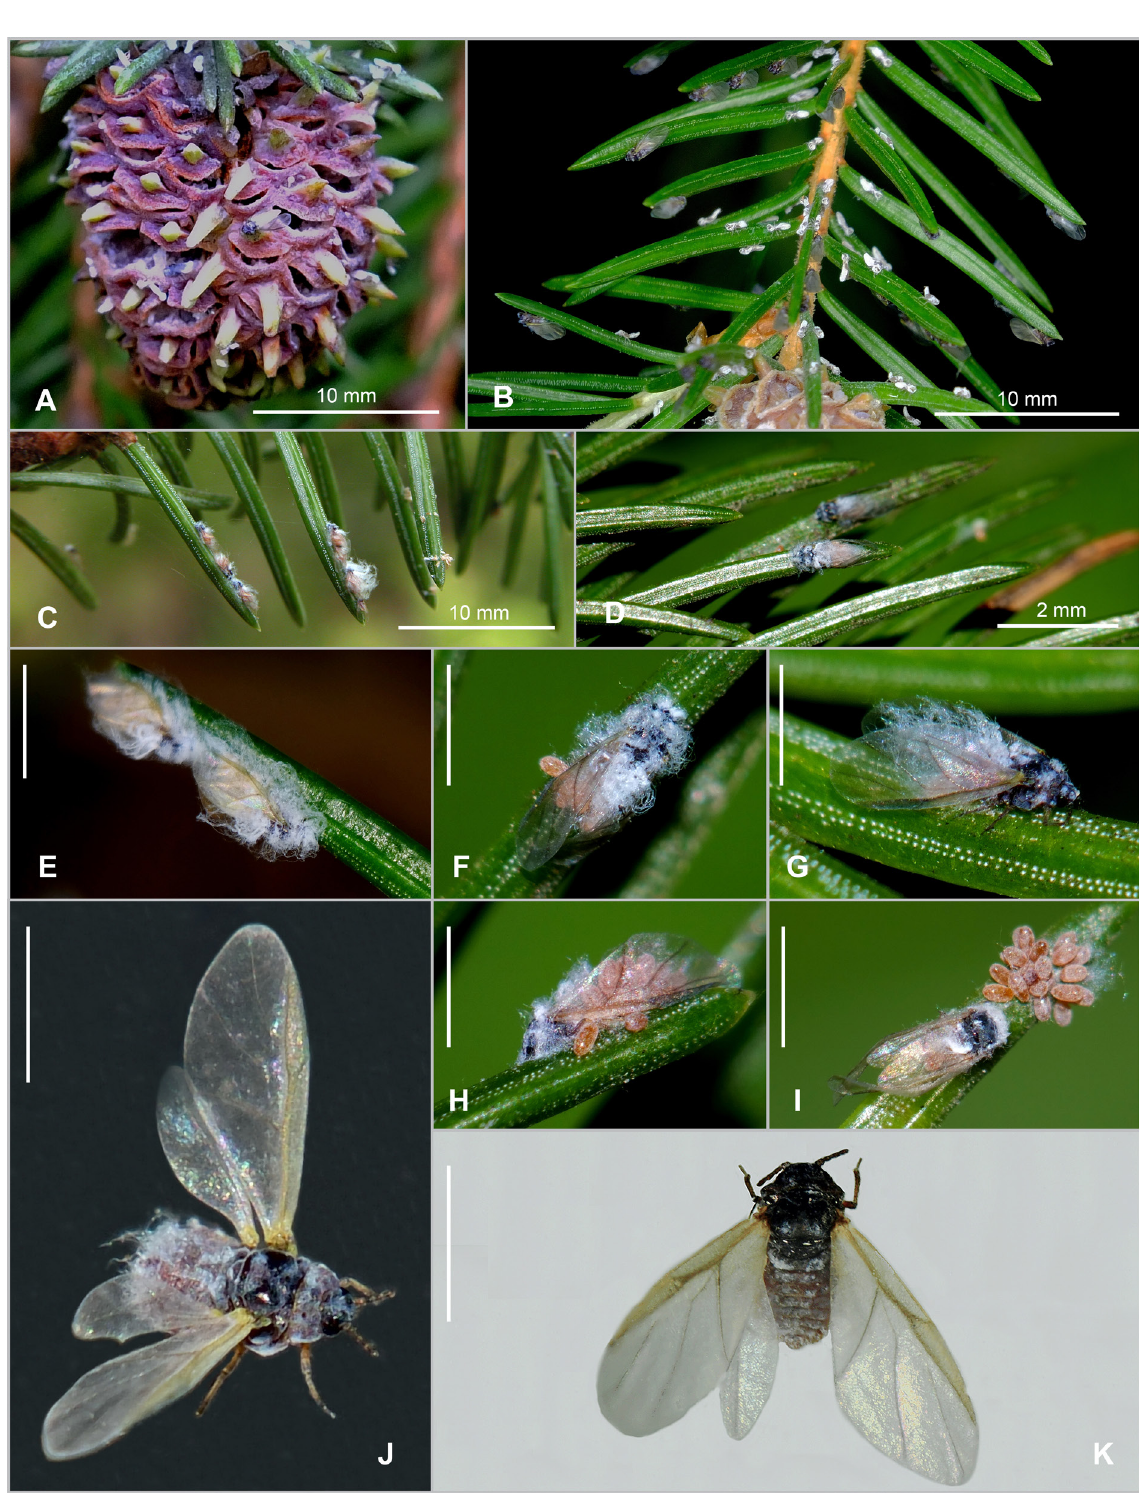
Fig. 11. Adelges (Adelges) tardus (Dreyfus, 1888) on Picea abies . A . Mature, opened gall with alate gallicolae on surface. B–I . Gallicolae laying eggs on needles in vicinity of their mother gall. J–K . Gallicolae in vitro . Scale bars for E–K: 1